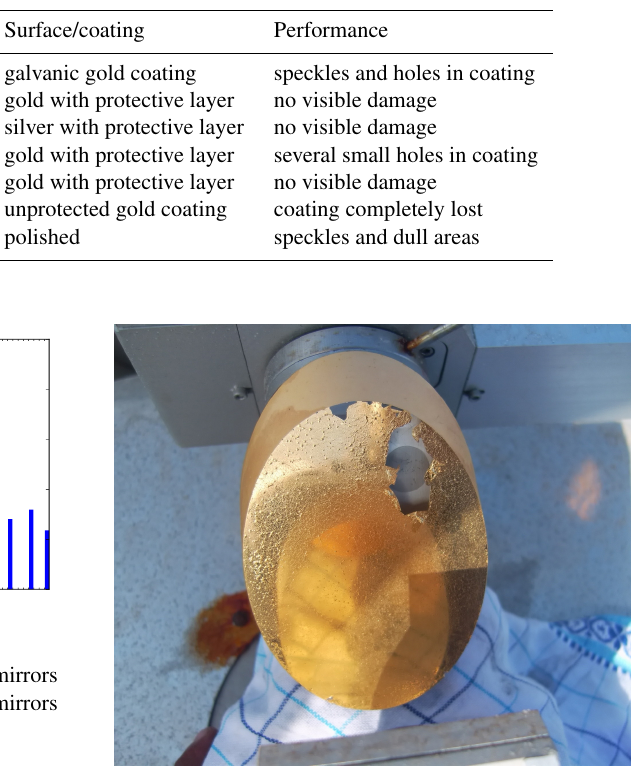
Figure 5. Surface damage on the protected gold-coated mirror (Lay- ertec) after 70days outside and six cleaning procedures. Photo: N.